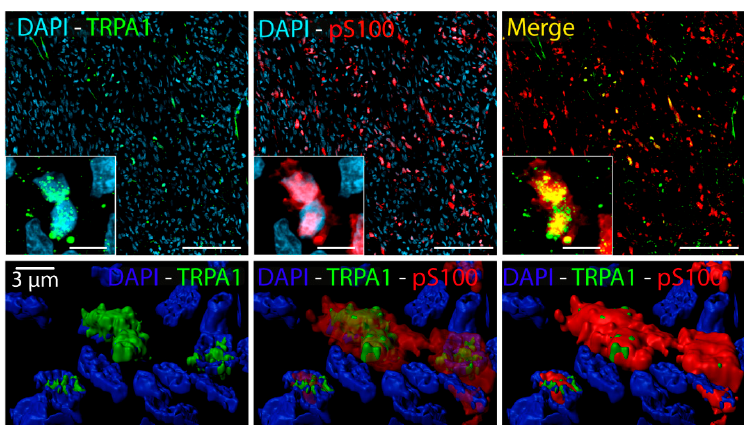
Figure 3. Representative images of a double immunofluorescence staining of pS100 (red) and TRPA1 (green) (Scale bars: 50 μ m, inset 10 μ m). Bottom panel: representative 3D surface reconstruction of TRPA1 and pS100 positive cells generated from structured illumination microscopic imaging using Imaris Software.